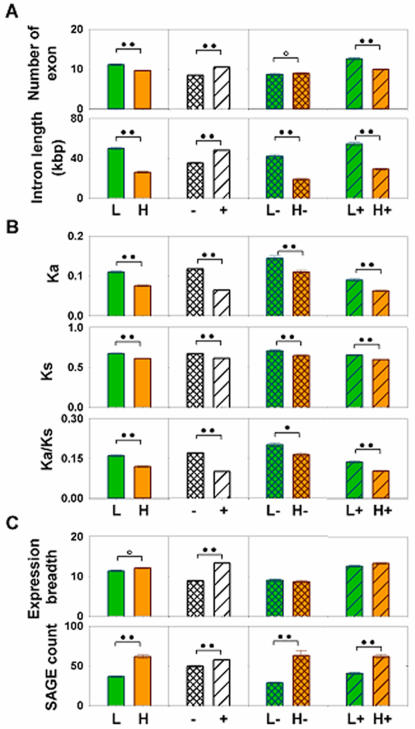
Quantitative comparison of gene subsets characterized in terms of PCI status, intron length/number, GC content, evolutionary rate, expression breadth and expression level.For expression levels, trimmed means (5%) with standard errors were used, with promoter non-overlapping (-, cross) and overlapping CpG islands (+, stroke) of different GC content. (Low, L, GC<40%, black; high, H, GC>65%, grey). P-value of nonparametric KS test is shown in circles (double dark, <0.001; single dark, <0.01; open, <0.05). A, Intron length and number; B, Evolutionary rate (Ka/Ks); C, Expression breadth and level.